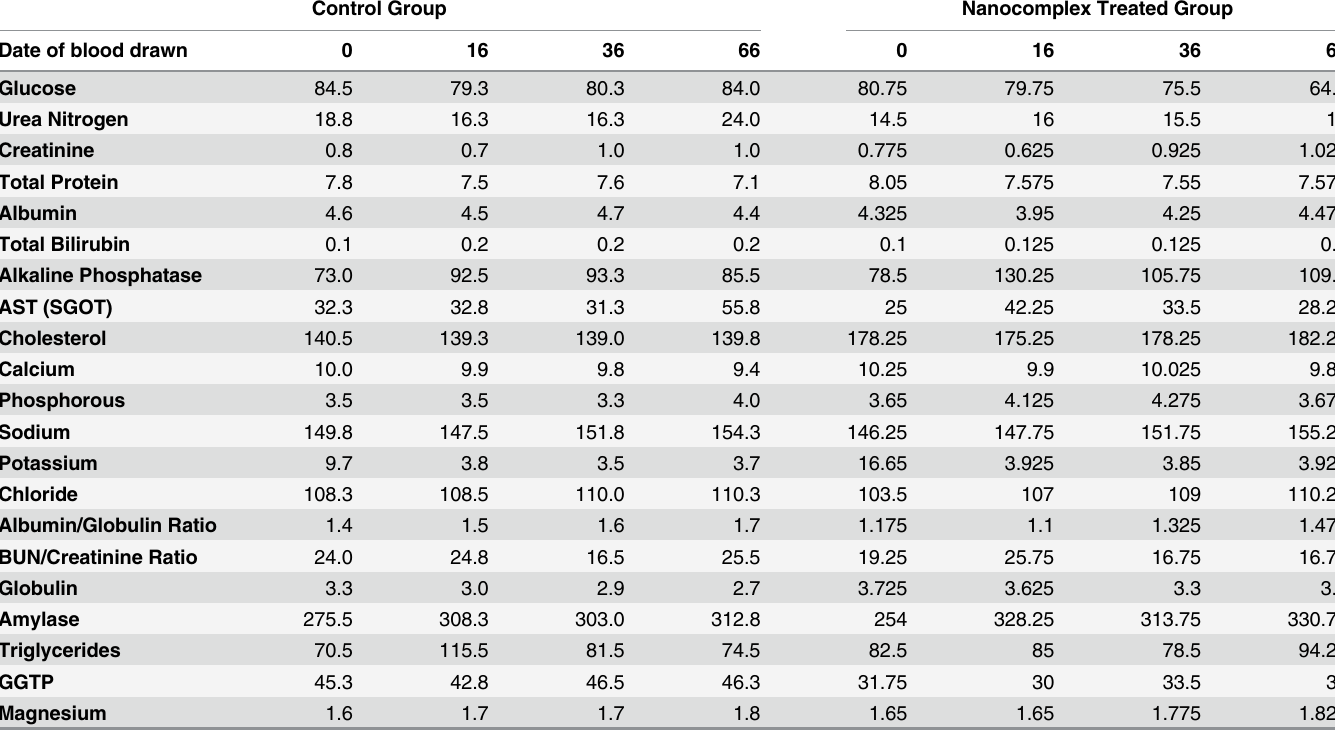
Table 2. Blood chemistry of control and nanocomplexes treated